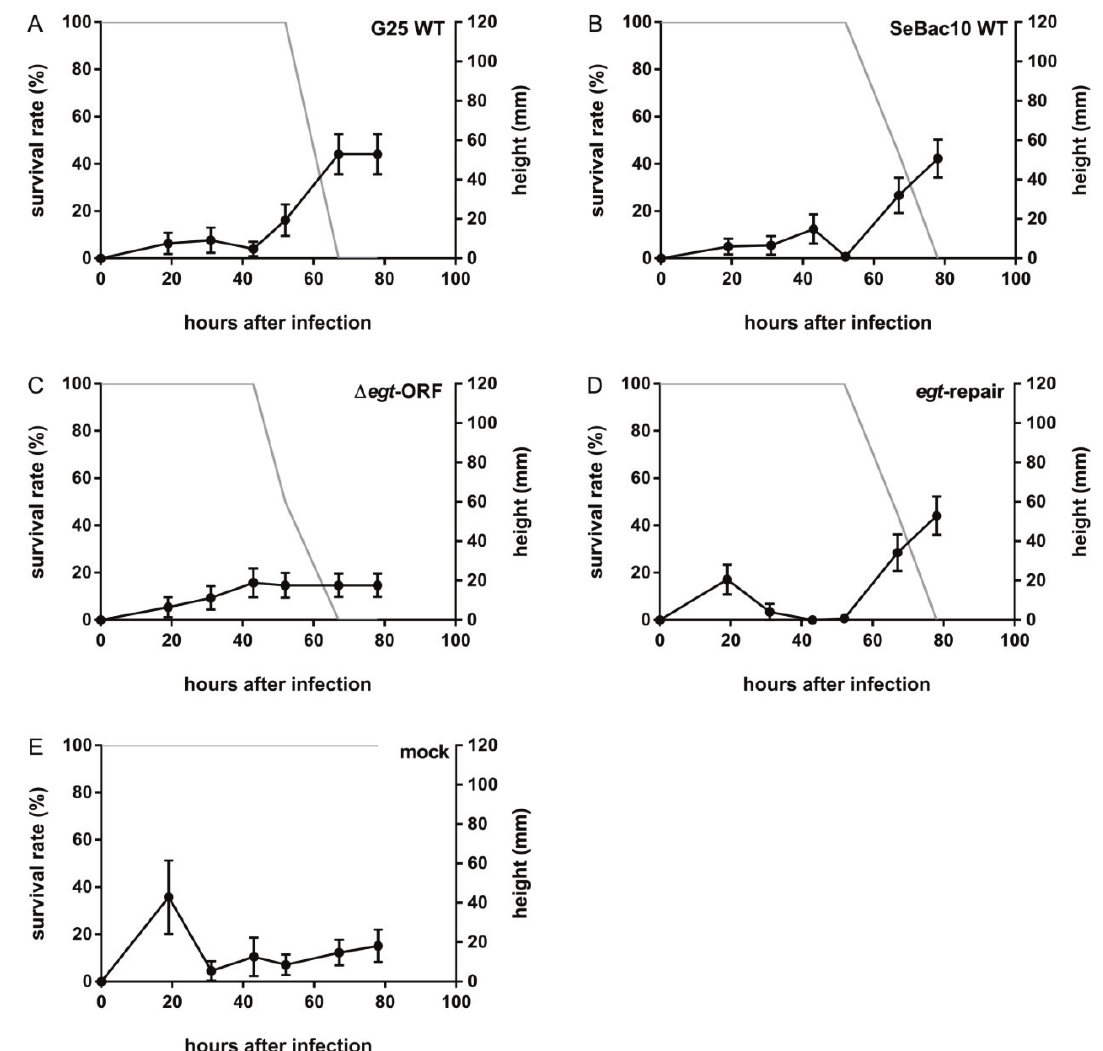
Figure 2. The effect of the deletion of the egt ORF on SeMNPV-induced tree-top disease in S. exigua larvae. Percentage surviving larvae (grey line) and height (mm) of larvae or cadavers (black line) were recorded at different time points after infection for 3rd instar S. exigua larvae infected with G25 WT ( A , n = 25), SeBac10 WT ( B , n = 27), Δ egt- ORF ( C , n = 24), egt -repair ( D , n = 29) or mock ( E , n = 10). Error bars represent the standard error of the mean